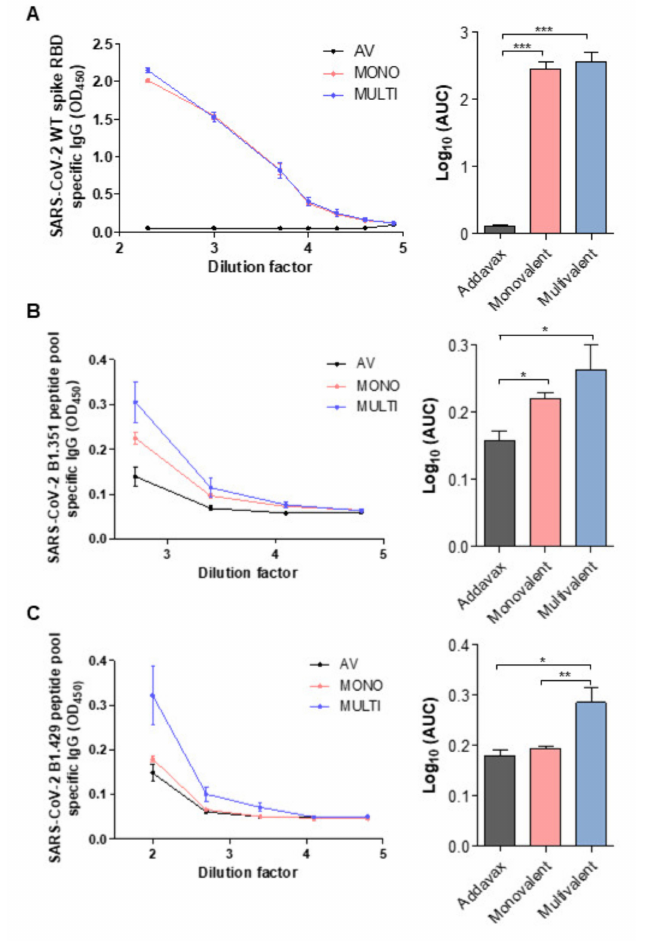
Figure 4. WT-, B1.315-, and B1.429-specific IgG responses following immunization with mono- and multivalent vaccine. ( A – C ) ELISA was performed using serially diluted serum samples from immunized animals. ( A ) WT-, ( B ) B1.315-, and ( C ) B1.429-specific antibody titers were quantified by area under the curve (AUC). Statistical comparisons were performed using Student t-test and statistically significant differences were presented as follows: p < 0.05 *, p < 0.01 **, or p < 0.001